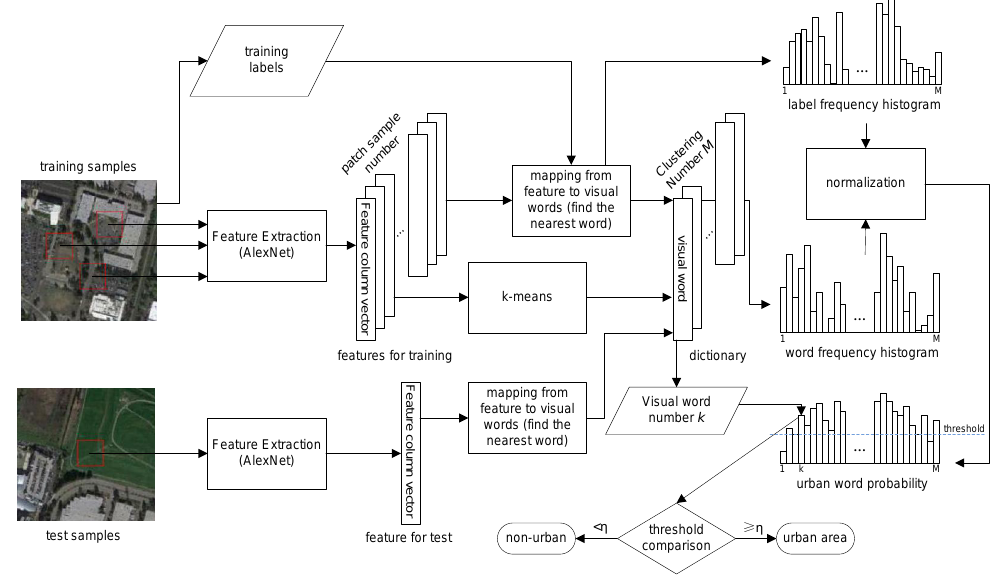
Figure 3. Details of each step in our proposed